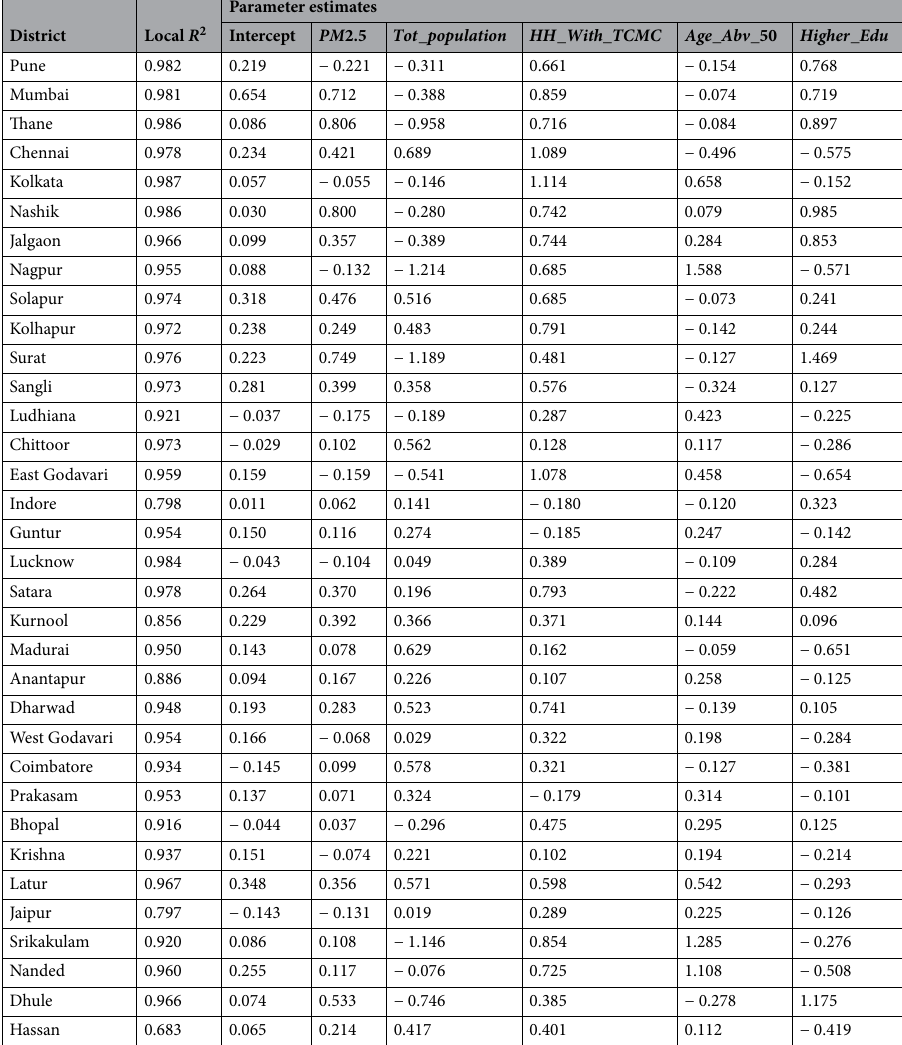
Table 7. Local R 2 and district-level parameter estimates by geographically weighted regression for some of the districts of India that are severely affected by COVID-19